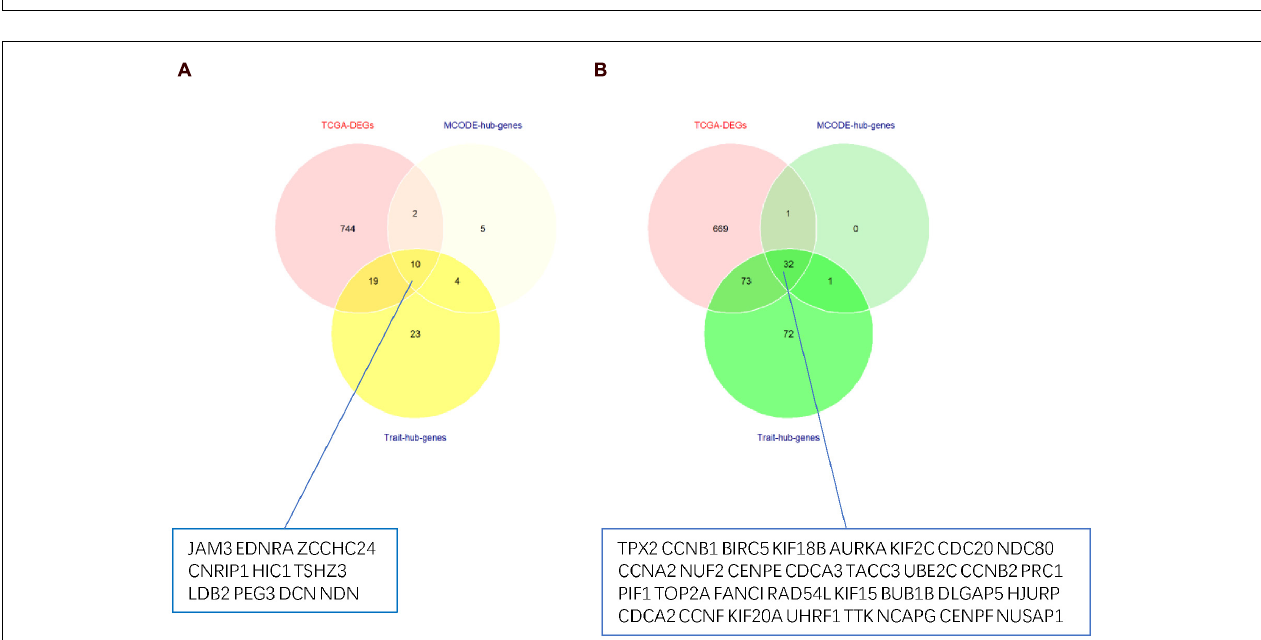
FIGURE 7 | Venn diagram of overlapping genes from TCGA-DEGs, MCODE-hub genes, and Trait-hub genes. (A) Hub genes from the yellow module. (B) Hub genes from the green module.